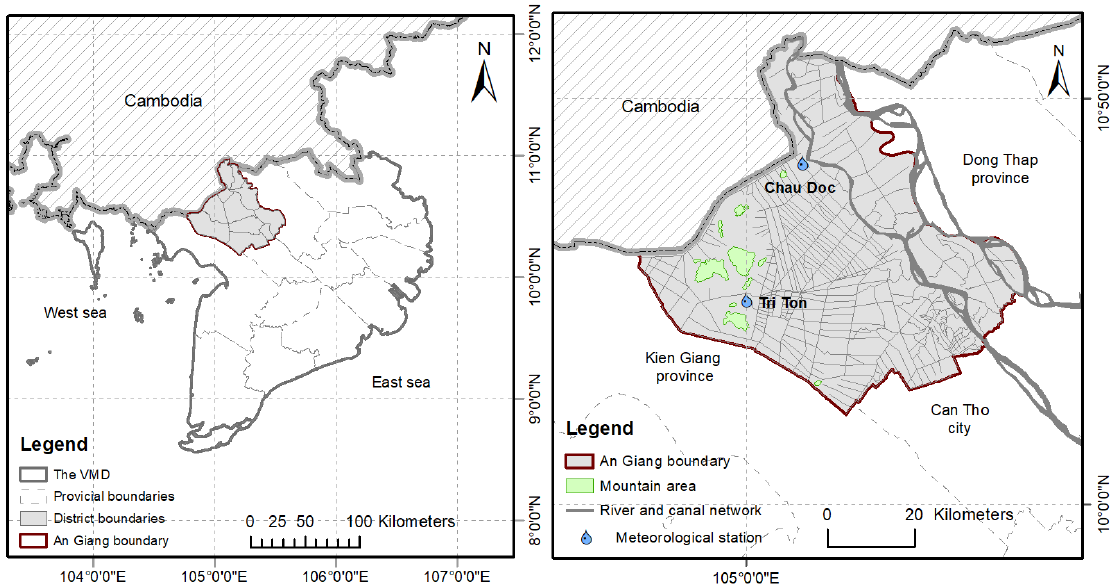
Figure 1. Location of An Giang province (left) and the utilized meteorological stations (right).